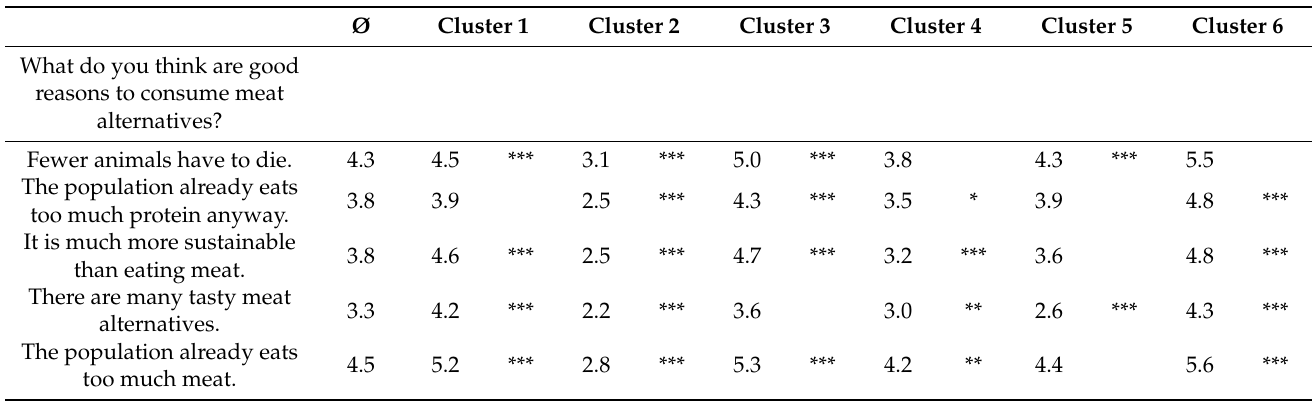
Table 6. Comparison of clusters with regard to respondents’ agreement with arguments in favour of consuming meat alternatives. Ø Cluster 1